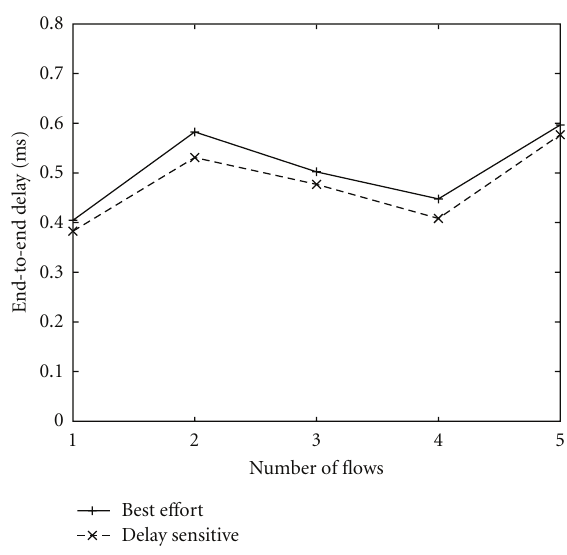
Figure 6: Scalability in terms of input load (for TCP tra ffi c).